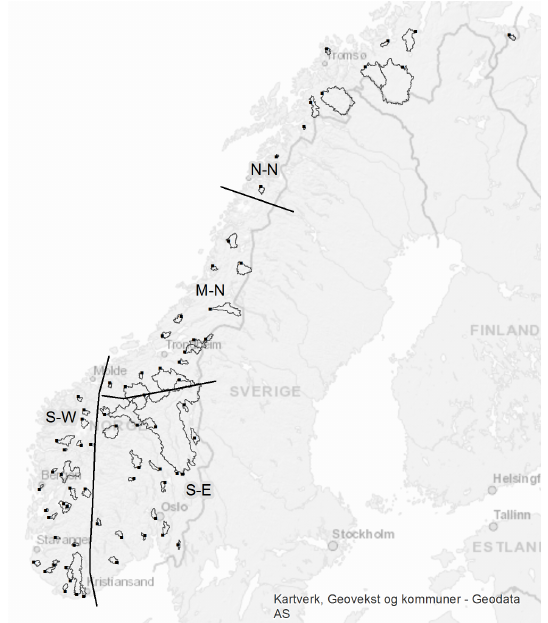
Figure 3. Location of the 71 catchments used to evaluate the new subsurface routine. The results presented in the next section are or- ganized with respect to the regions south-east (S-E), south-west (S- W), mid-Norway (M-N) and Northern Norway